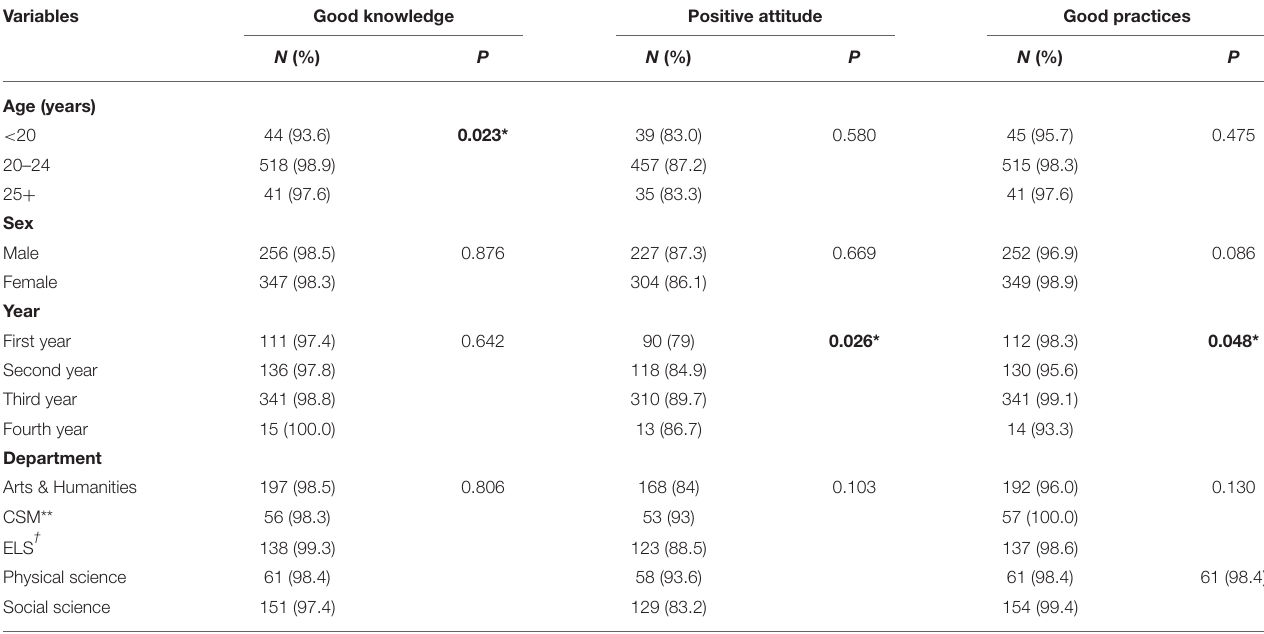
TABLE 4 | Distribution of good knowledge, attitude, and practice based on the demographic characteristics of the participants. Variables Good knowledge Positive attitude Good practices